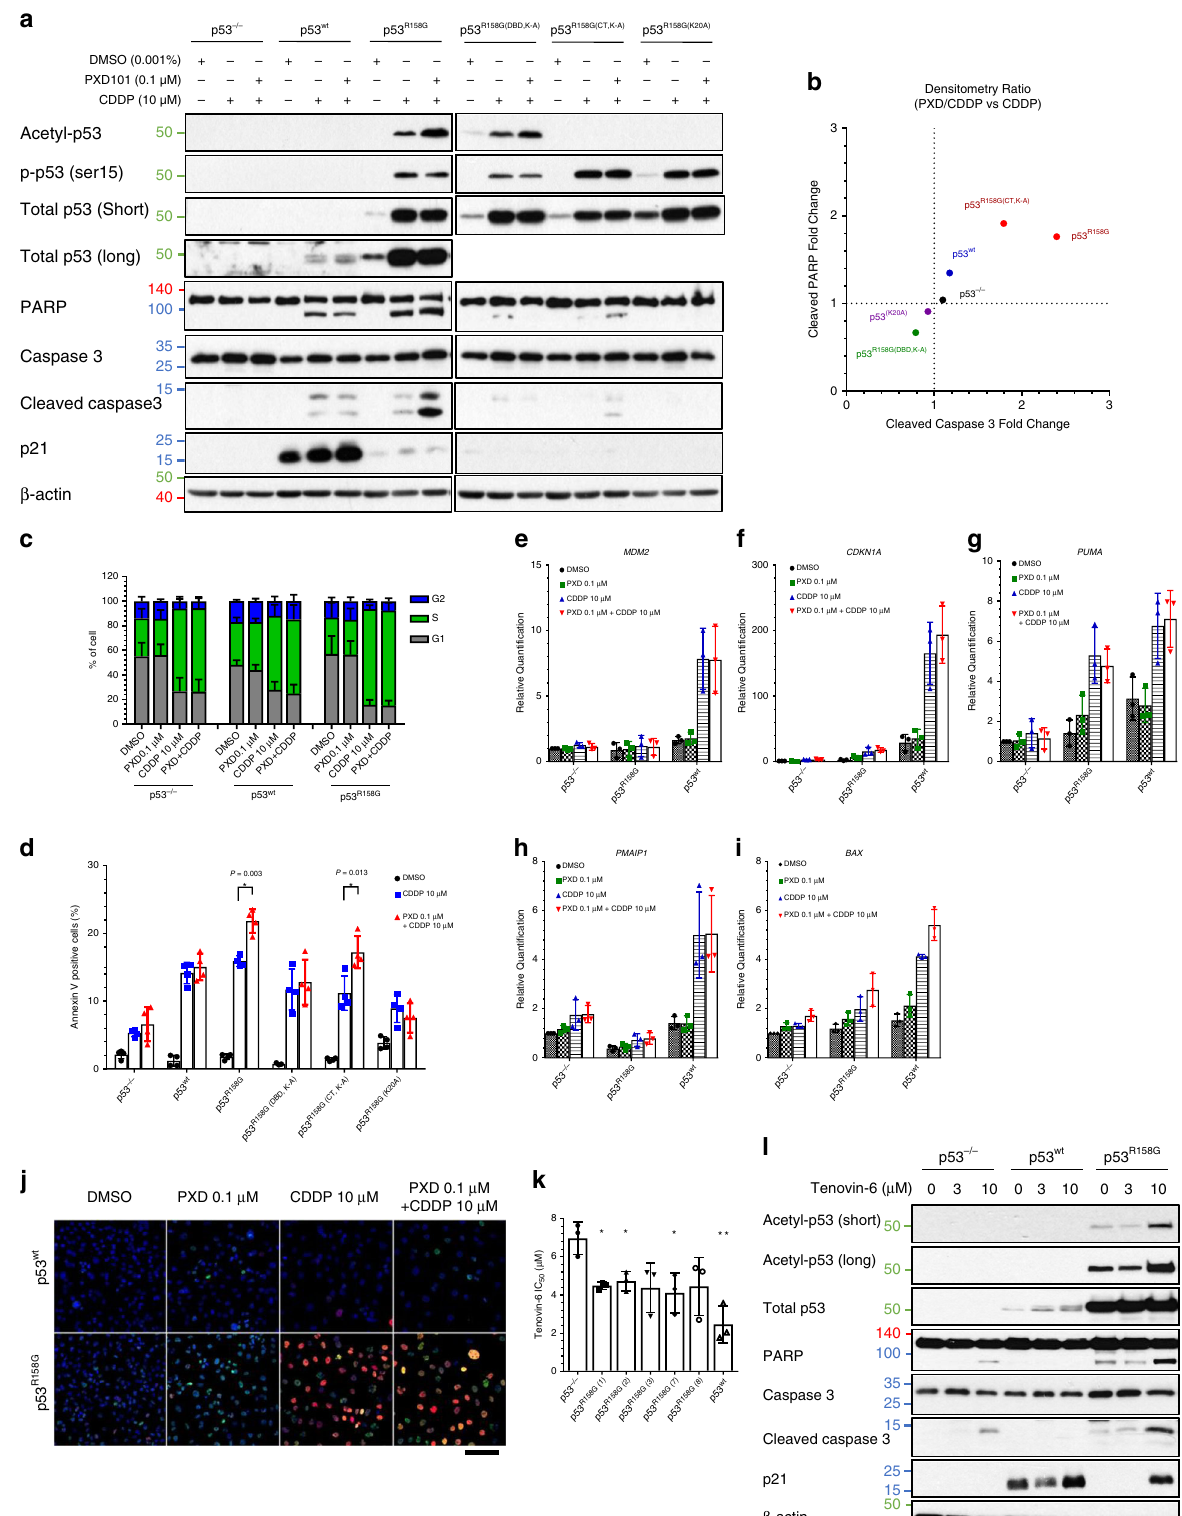
cavity that changes the structure of the DBD – most notable is the loss of the stability of helix H1, which is responsible for dimer formation of activated p53 (Supplementary Fig. 6A, C) — that could likely disrupt key interactions between the DBD (K120, R280, R248) and DNA. Interestingly, acetylation of the Lysine